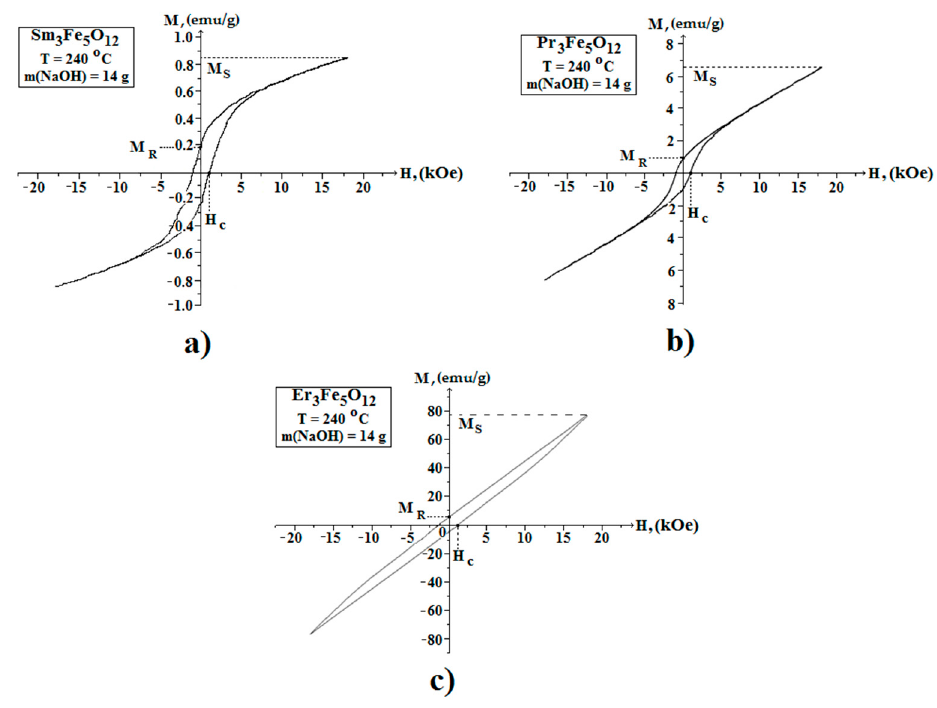
Figure 9. Magnetic hysteresis loops of the Sm 3 Fe 5 O 12 ( a ), Pr 3 Fe 5 O 12 ( b ), and Er 3 Fe 5 O 12 ( c ) powder samples. Magnetic experiments were carried out at room